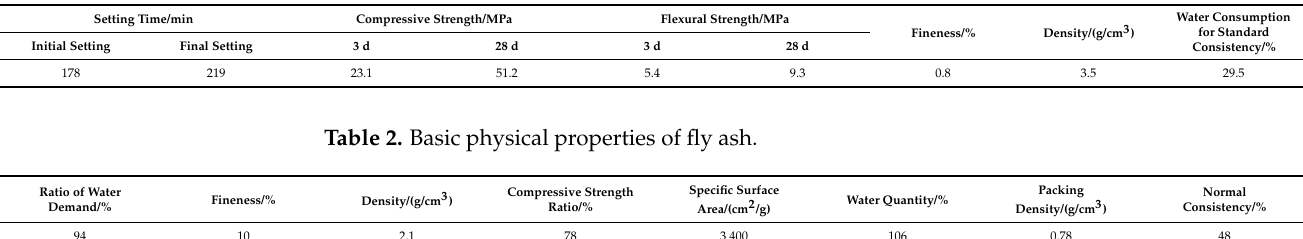
Table 1. Basic physical properties of cement.